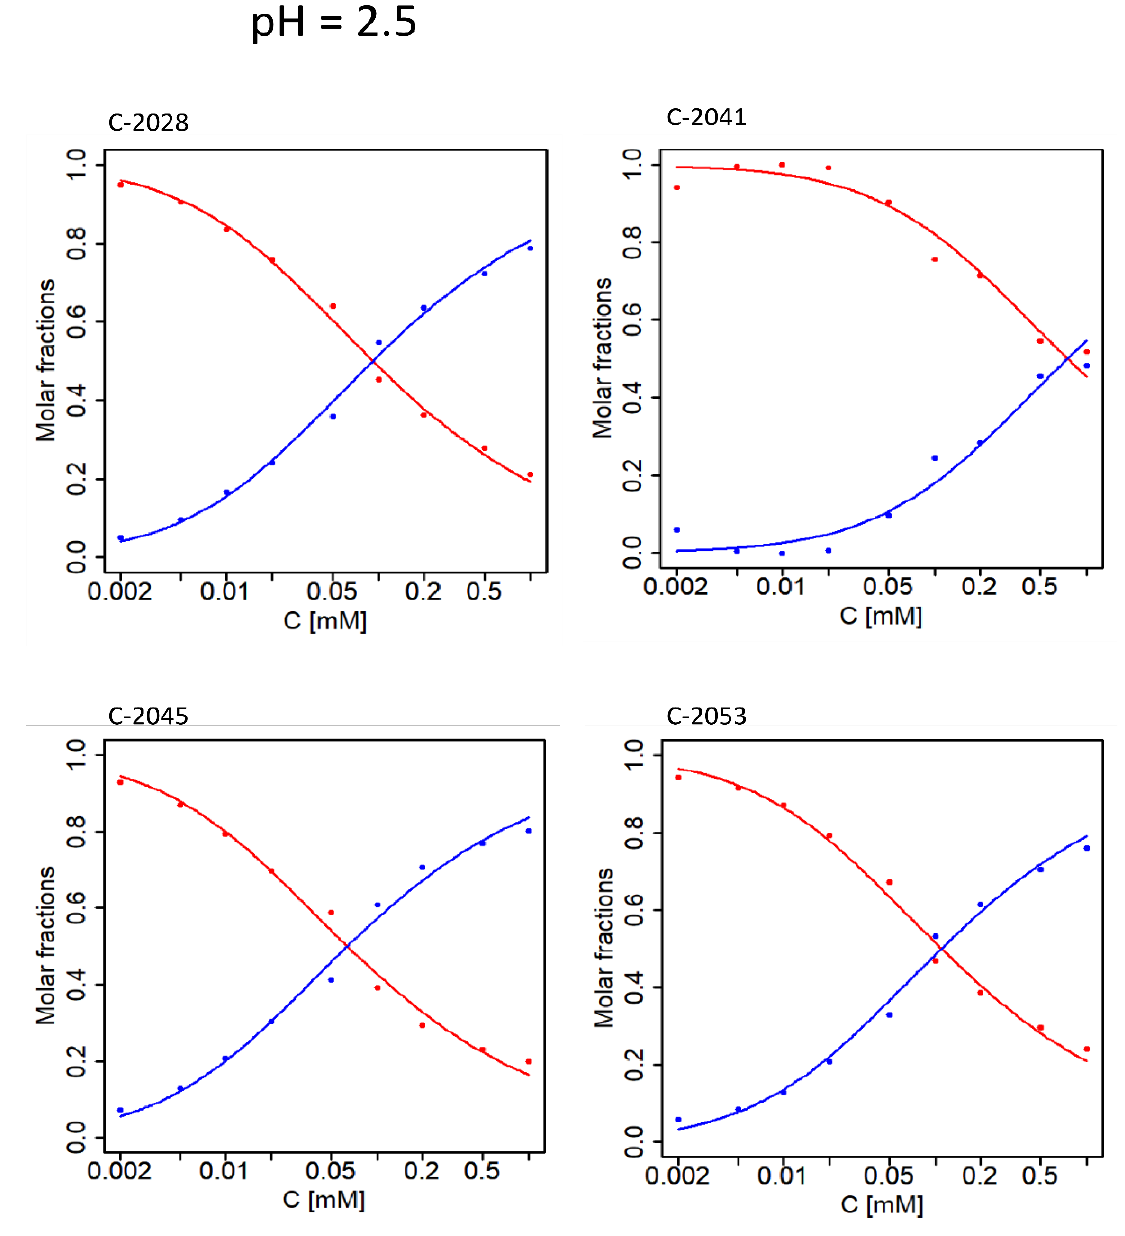
Figure 6. UA molar fractions for UAs studied at pH = 2.5 and 35 ◦ C. Points—optimal molar fractions; curves—the best fit of the theoretical model of dimerization to the data. Red color—monomer, blue